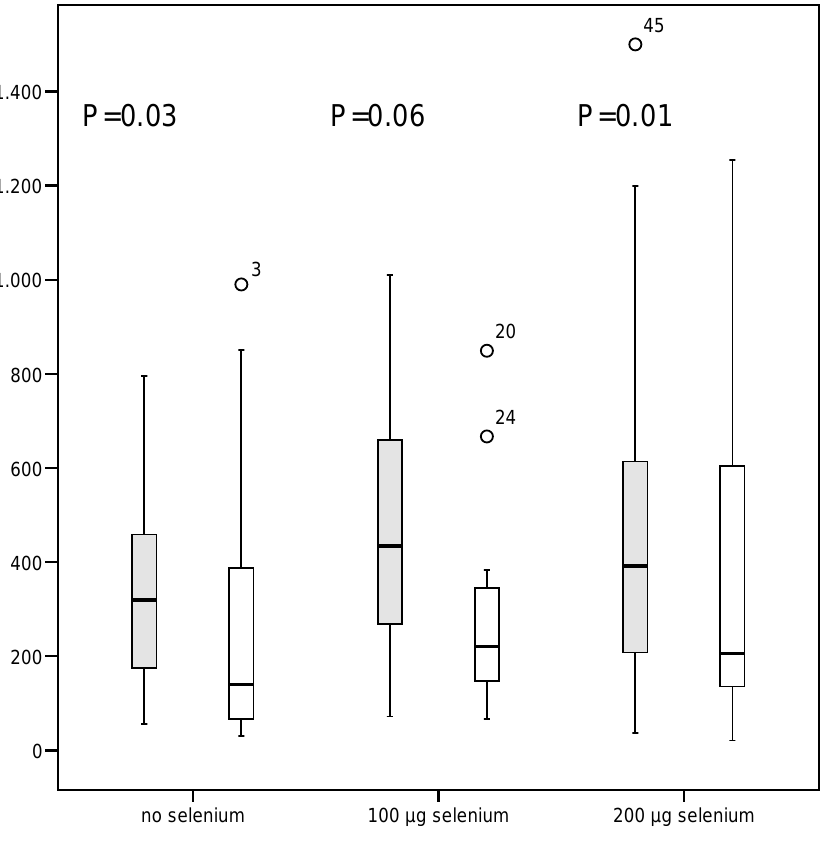
FIGURE 2. Boxplot (median, first, and third quartile, whiskers 3 rd /97 th percentile) showing Tg Ab titers [U/ml] at diagnosis and after 12 months. Significant decrease in Tg Ab concentration (no selenium [group A] and 200 µg selenium [group